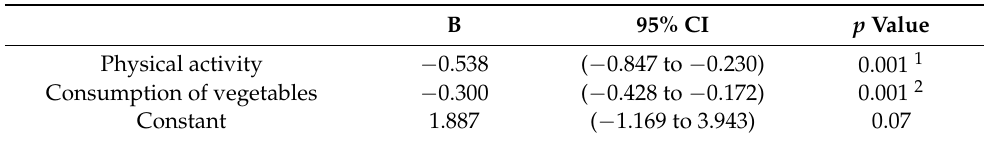
Table 6. Associations of IL-6 with modifiable lifestyle habits using Multiple Linear Regression analysis in the entire